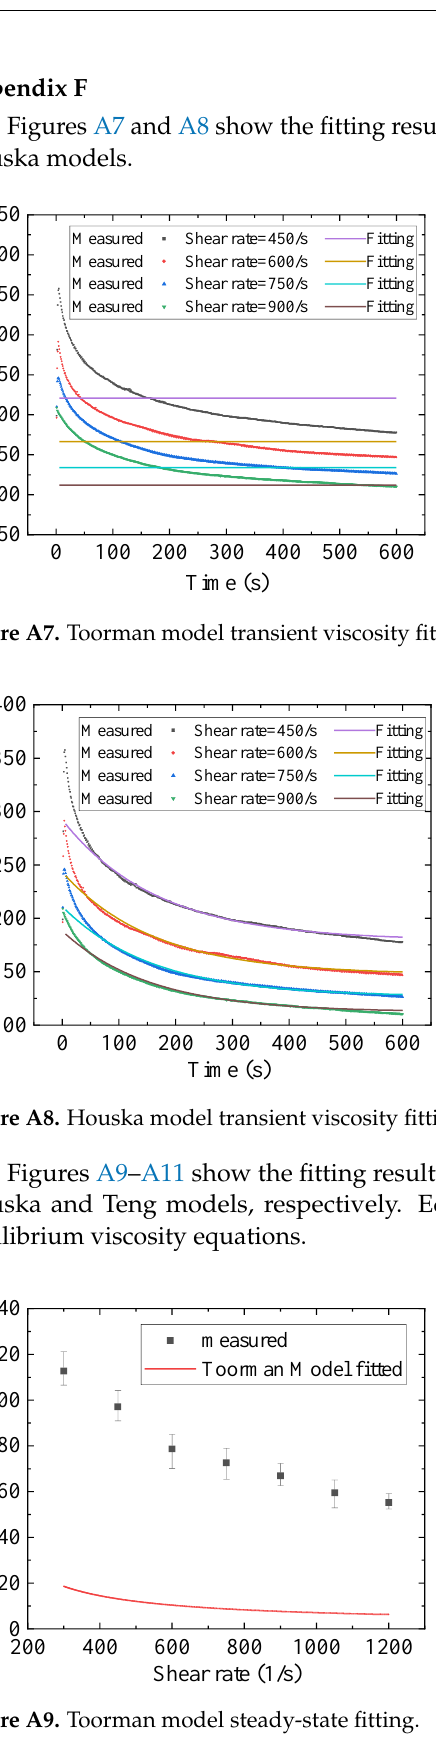
Figure A6. Hysteresis loop experiment after high-speed shearing.